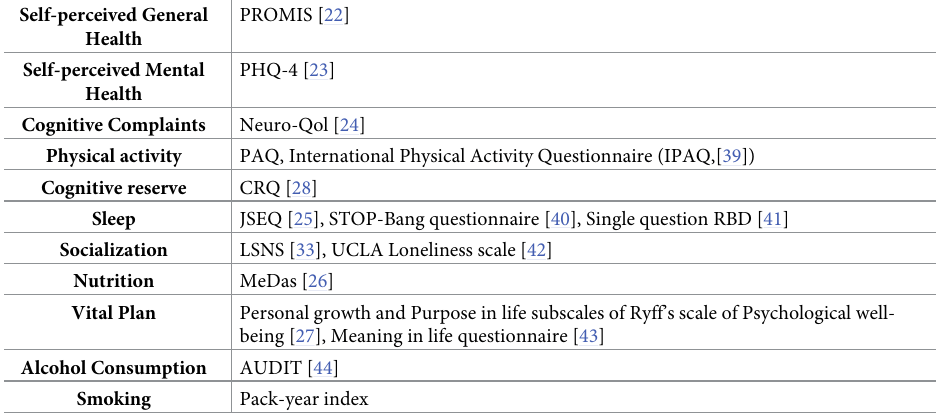
Table 3. Questionnaires administered for the 1-year